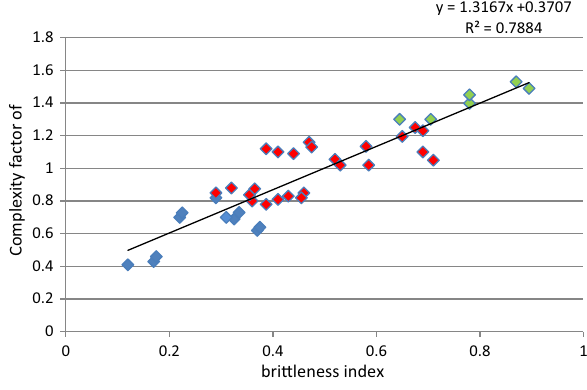
Fig. 14 Relationship between brittleness index and complexity factor of rock failure